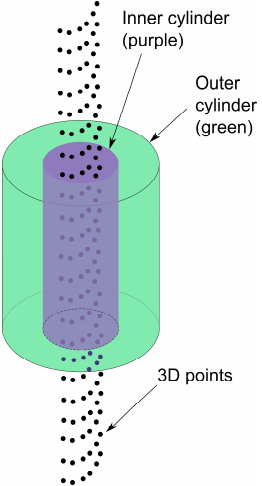
Figure 4. A mask consisting of two coaxial cylinders is used as a model of a pole in the algorithm. The green volume surrounding the pole that is inside the purple cylinder should be almost empty of points.